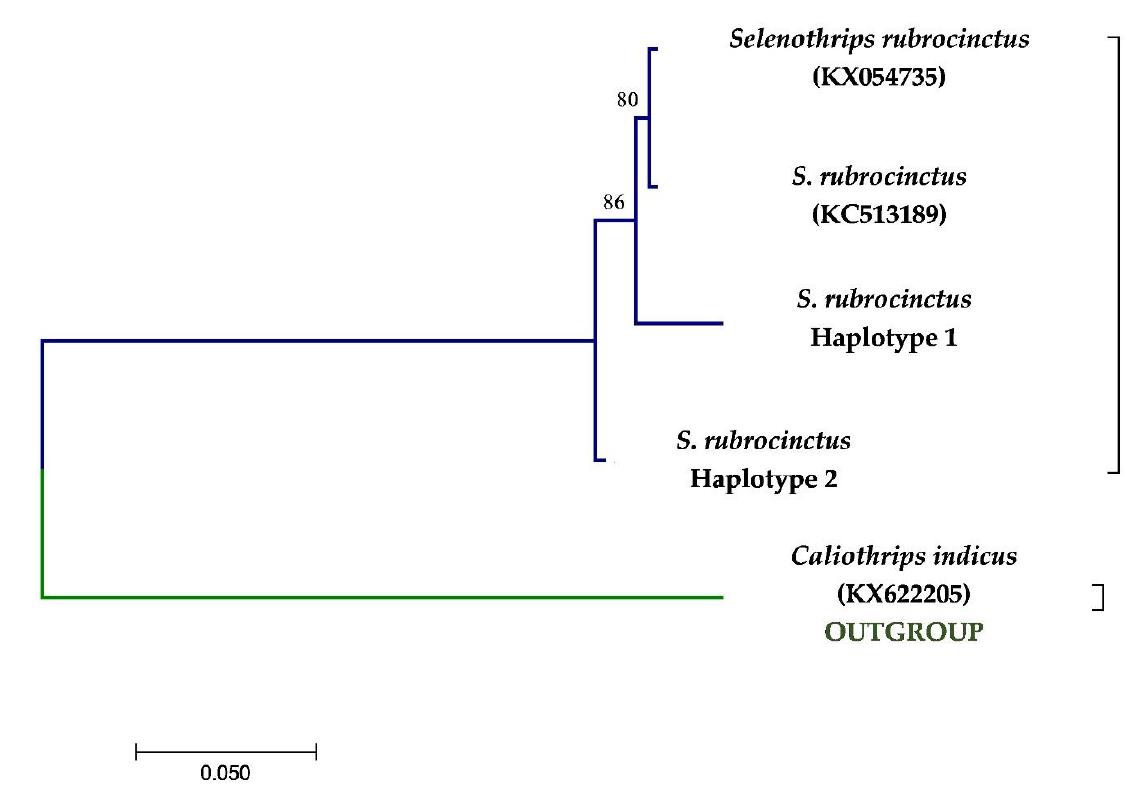
Figure 1. Bootstrap consensus tree generated using the Neighbour-Joining method and general time reversible (GTR) G + I (gamma + invariant) model showing the genetic differences and relationship among S. rubrocinctus haplotypes obtained by mt-COI sequences. S. rubrocinctus sequences [38,39] available in NCBI are included and Caliothrips indicus was used as an outgroup. Species names and GenBank accession numbers are shown in the figure.